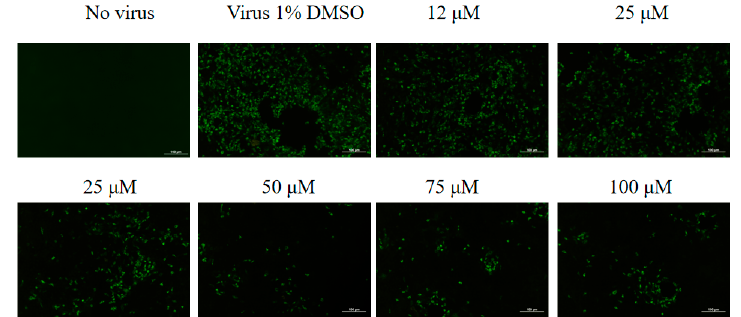
Figure 3. Anti-foot-and-mouth disease virus (FMDV) activity of mizoribine detected by immunofluorescence microscopy. IBRS-2 cells were infected by 100 TCID 50 O / MY98 / BY / 2010 with or without treatment by increasing concentrations of mizoribine for 12 h. The whole viral proteins were determined by IFA, the green fluorescence represents the intracelluar distribution of FMDV. Scale bars indicate 100 µ